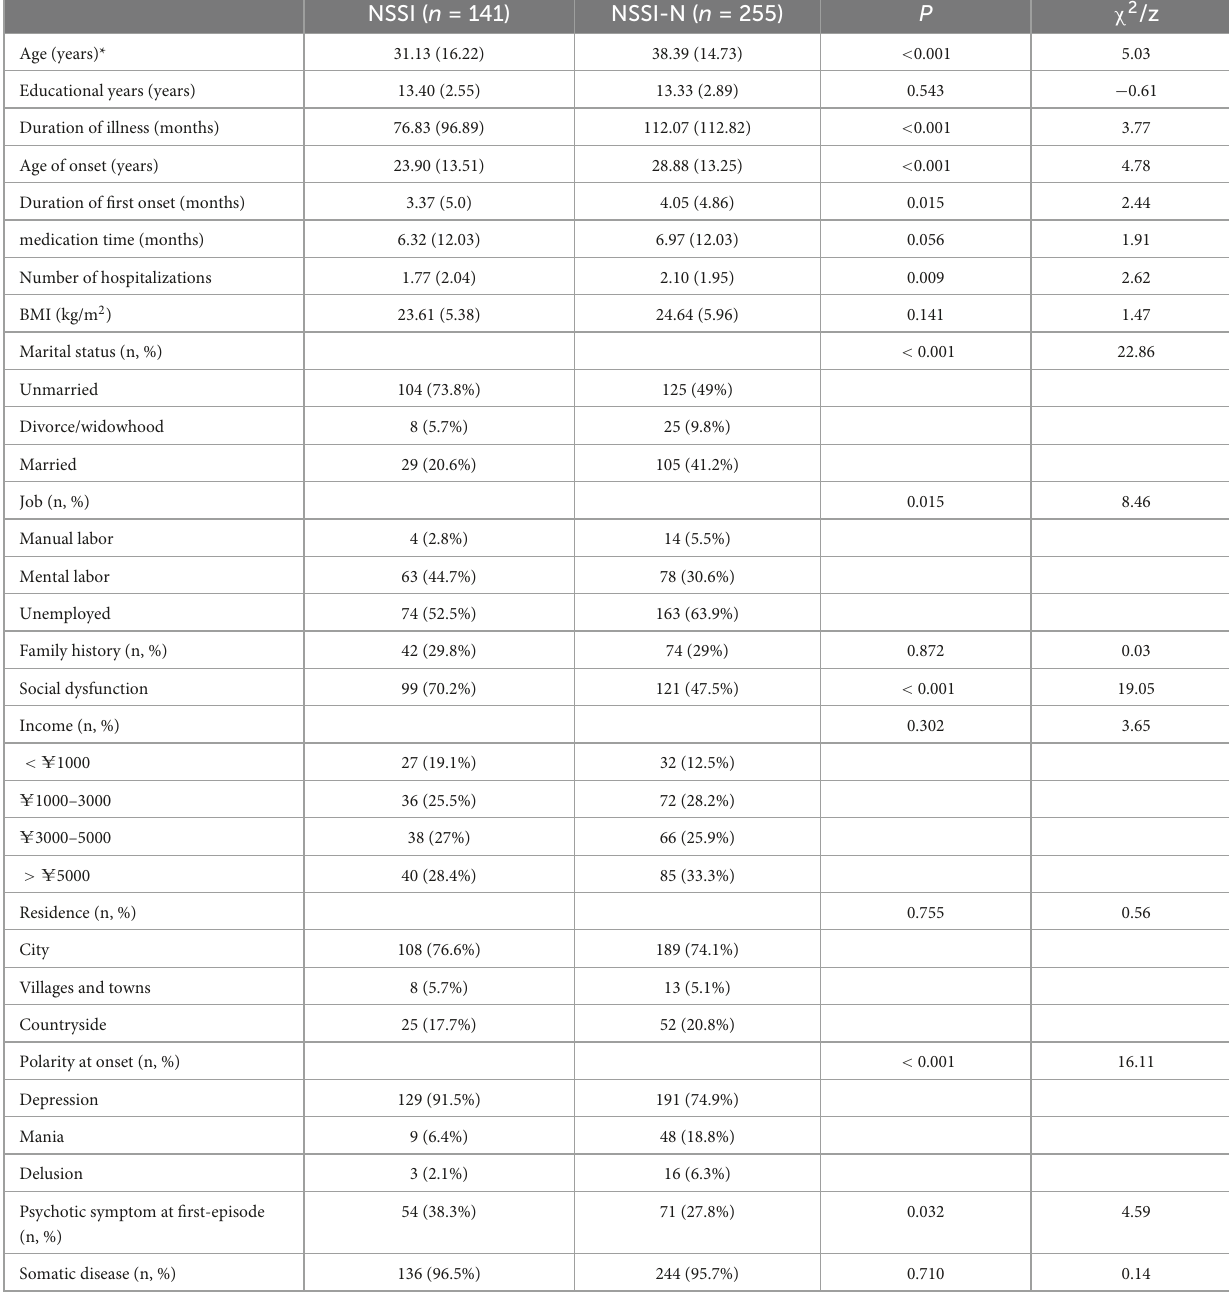
TABLE 1 Demographic information and clinical